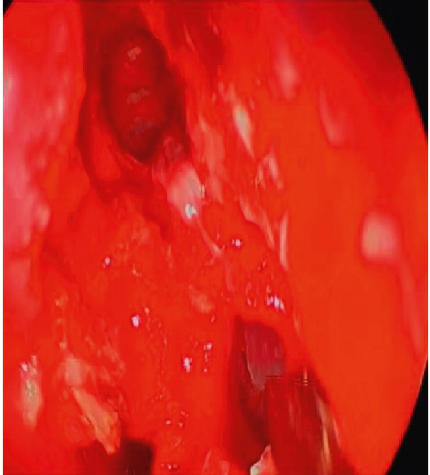
Figure 3: The intraoperative endoscopic view of the left sphenoid mass preoperative and postoperative.